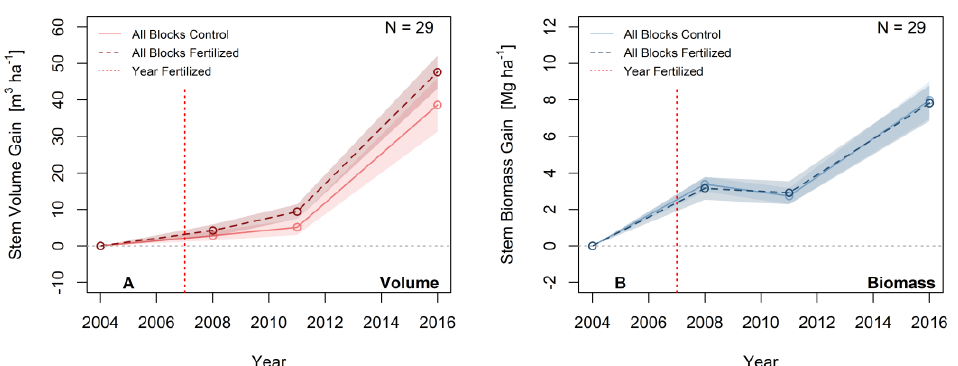
Figure 5. LiDAR block-level average (line) and standard error (shadow) of stem volume ( A ) and biomass ( B ) cumulative increments (gain) for control blocks (solid) and fertilized blocks (dashed).